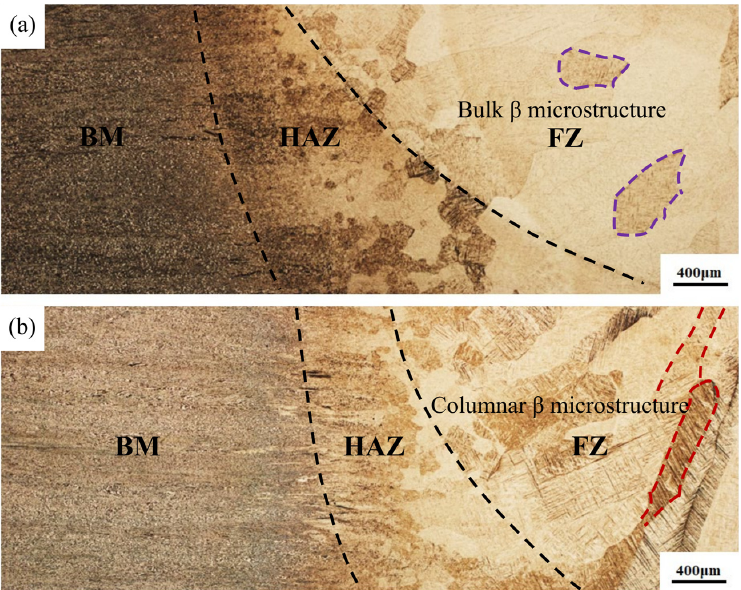
Figure 5. Microstructure of flux-cored wire and cable wire welding joints comparison: ( a ) flux-cored wire welding joint; ( b ) cable wire welding joint.